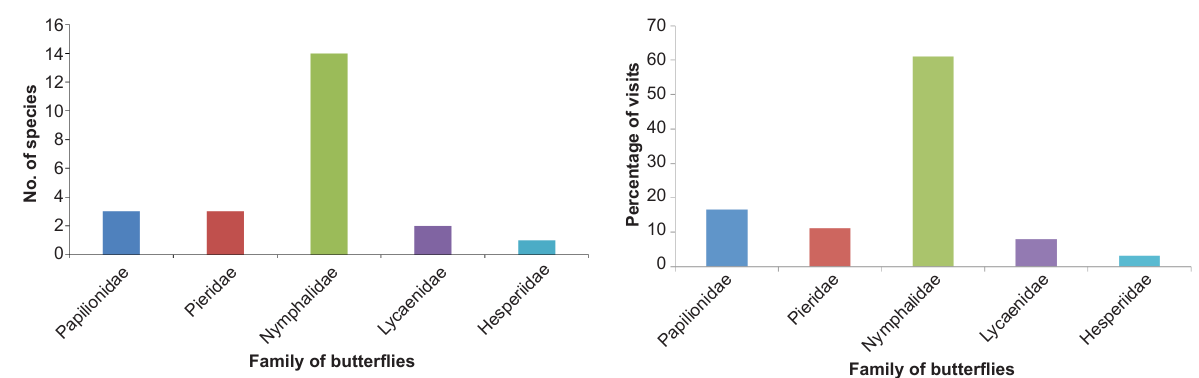
Figure 2. Family-wise percentage of foraging visits of but - terflies on Chromolaena